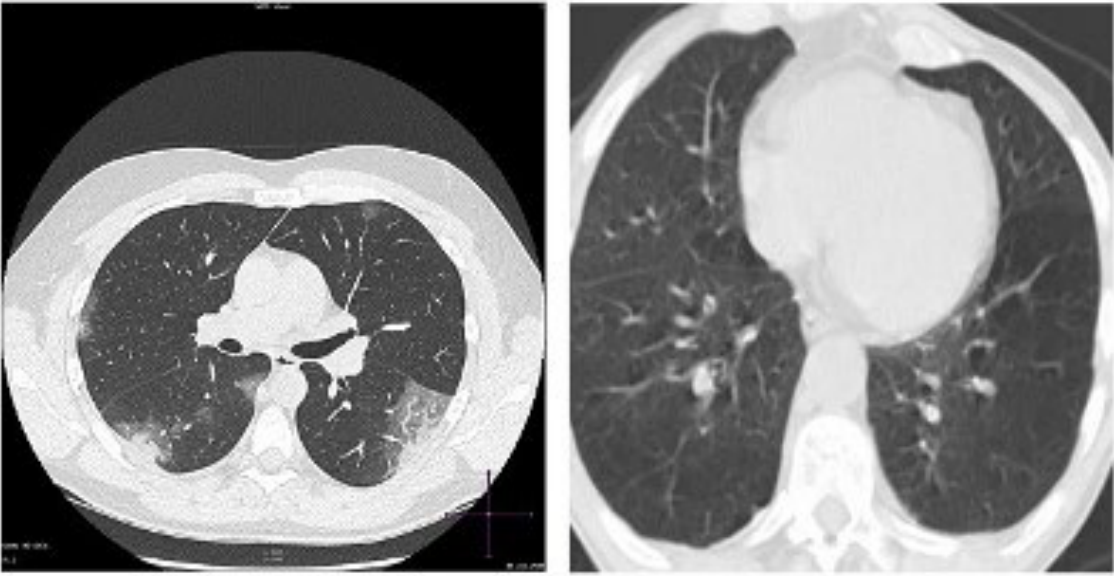
Figure 6. CT scan Image. Left : COVID-19. Right : Normal.